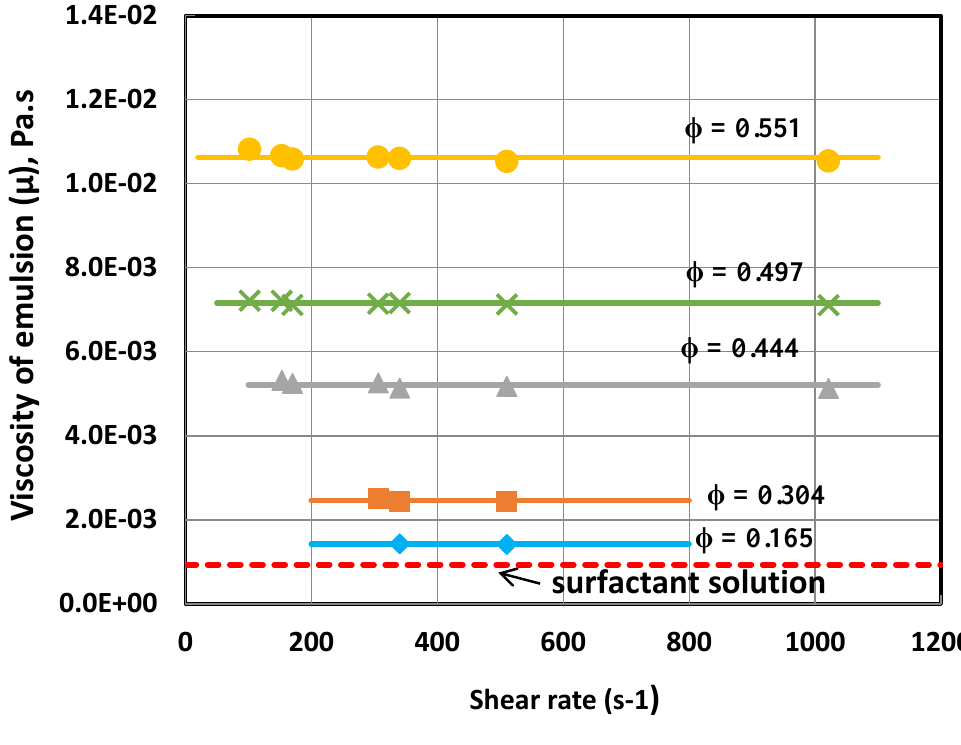
Figure 5. Viscosity of emulsions as a function of shear rate.